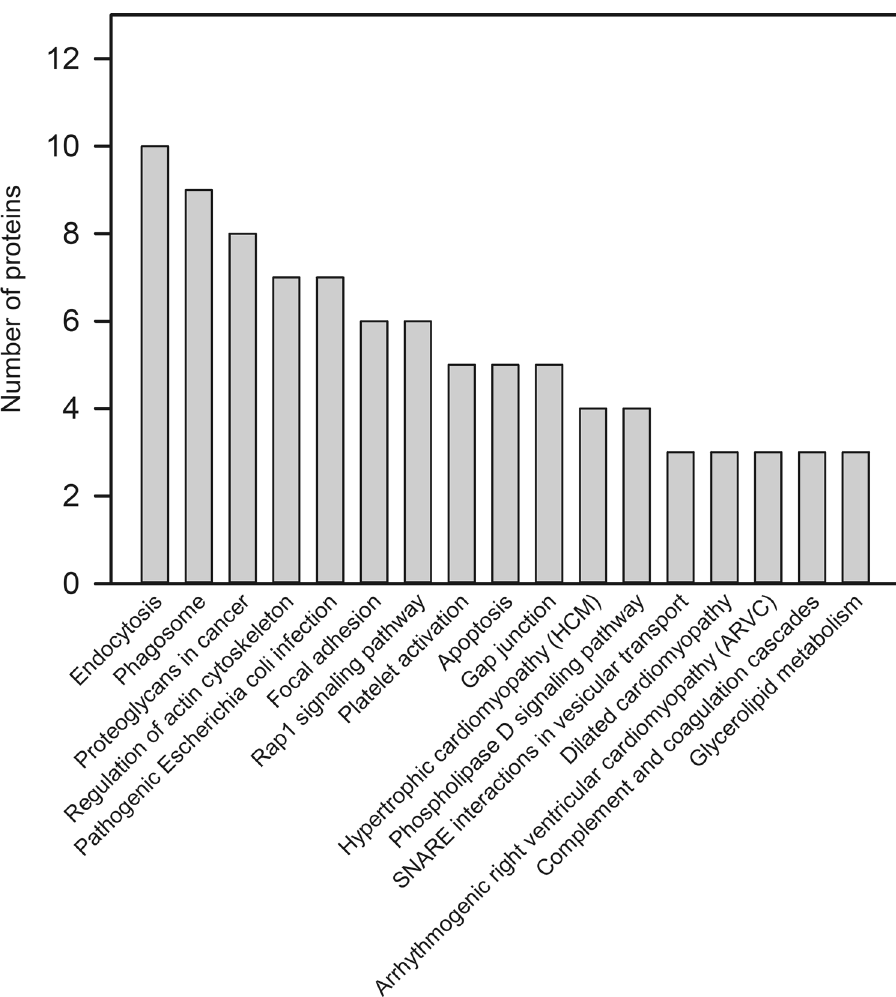
Figure 3. KEGG pathways analysis of differentially accumulated proteins from HepG2.2.15 cell treated with JS-K (http:// www. genome. jp/ kegg/ pathw ay.